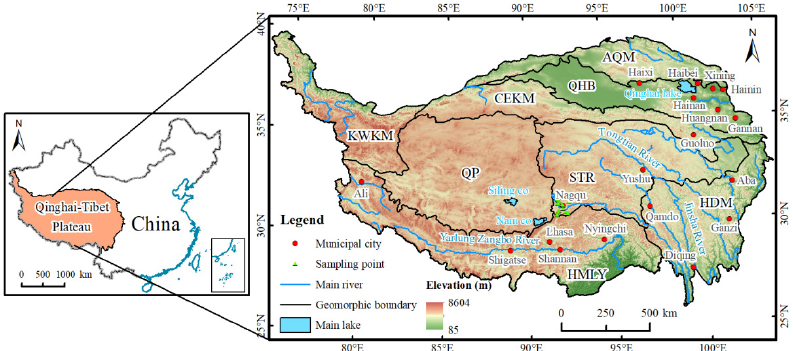
Figure 1. Map of the Qinghai–Tibet Plateau (QTP). AQM is the high valley area of the Altun–Qilian Mountains. QHB are the high mountain areas of Qaidam-Yellow River-Huangshui River Basin. KWKM are the high mountain areas of Karakorum and Western Kunlun Mountains. CEKM are the high mountain areas of the central and eastern Kunlun Mountains. QP are the lake and basin areas of the Qiangtang Plateau. STR are the mountains sources of the Yangtze River, Yellow River, and Lancang River (Three Rivers or Sanjiangyuan) and the valley bottom of the upper reaches of Three Rivers. HMLY are the high mountain areas of the Himalayan Mountains. HDM are the high mountain and valley areas of Hengduan Mountains. (Appendix A of Table A1 for acronyms). With eight geomorphological divisions [49], the topography of the QTP is complex, with high elevation mountains and many basins, canyons, and lakes (Appendix B Table A2). The eight factors are shown in Figure 2. The elevation of the QTP is higher in the west and lower in the east. The alpine areas on its edge bear large undulations and low interior. Affected by its own geographical location, the QTP has formed a unique plateau climate zone. The precipitation of the QTP decreases from southeast to northwest (Figure 2b). The temperature has a clear latitudinal zonality, decreasing from south to north (Figure 2c). The land cover types of the QTP are dominated by grassland (Figure 2h), which is widely distributed in all parts of the QTP and mainly has low to medium canopy cover. Other land cover types include Gobi, bare land, sandy land, saline–alkali land, and other areas with vegetation cover below 5%, which are distributed in the northern part of the QTP. Forests are mainly distributed in the southeast of the QTP due to the influence of precipitation and temperature. Cultivated, urban, and rural built-up lands are mainly distributed in low-lying, warm valleys with abundant water sources.